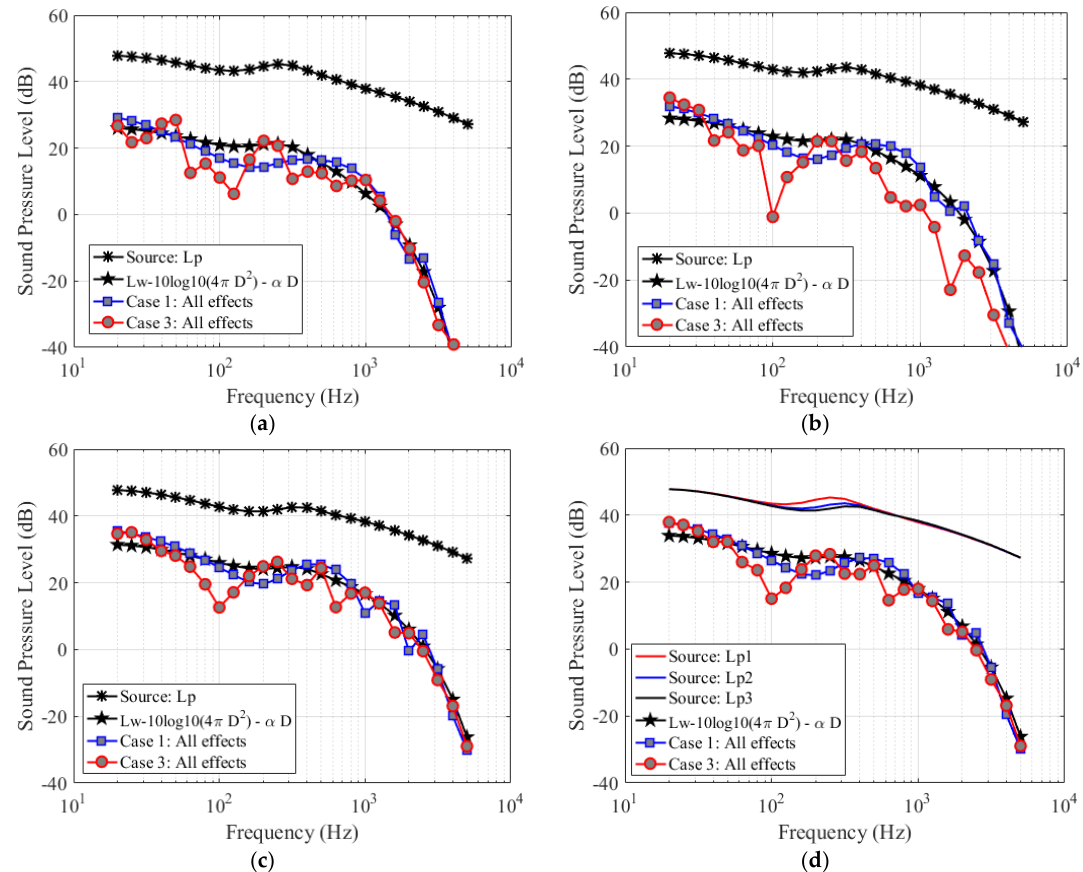
Figure 19. Receiver is fixed at x = 2500 m away from wind turbine #1, and the receiver height is 2 m.